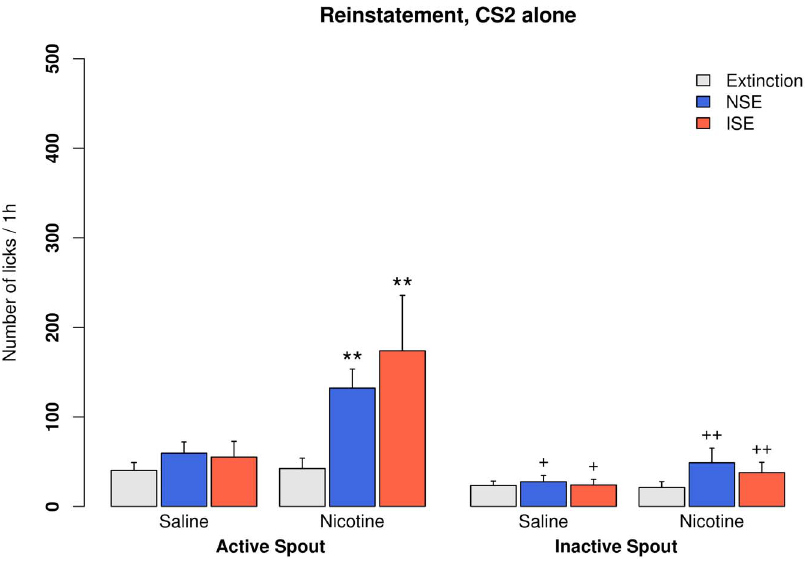
Fig. 4. Context-induced drug-seeking in rats self-administering saline or nicotine with CS 2 . Extinction training was conducted in operant chambers different from those used in the self-administration sessions. Two reinstatement tests were conducted consecutively in the presence of a demonstrator rat. The demonstrator rat either provided a neutral social environment (NSE, i.e., did not have access to the olfactogustatory cue), or an inducing social environment (ISE, i.e., consuming olfactogustatory olfactogustatory cue). The sequence of tests were counterbalanced between rats. **: p , 0.01, compared to extinction; + : p , 0.05, compared to the active spouts; ++ : p , 0.01, compared to the active